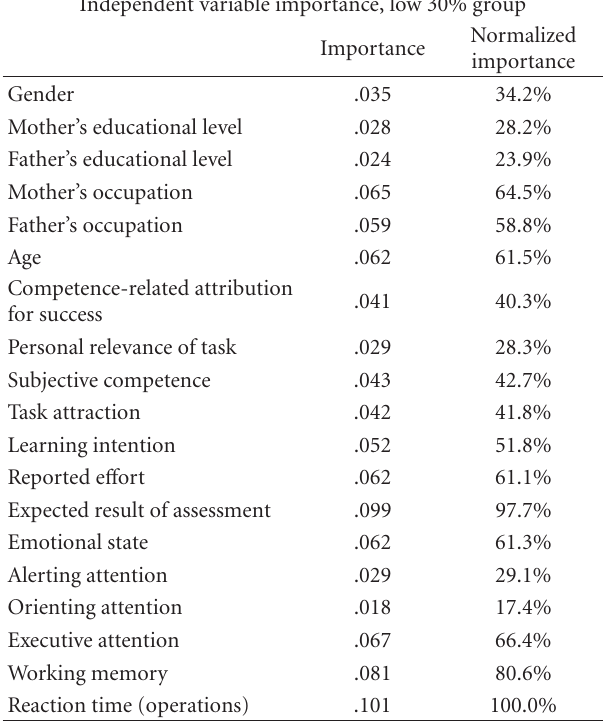
Table 2: Relative importance of the top variables participating in the model for the predictive classification of the lowest 30% of scores in the mathematics test.